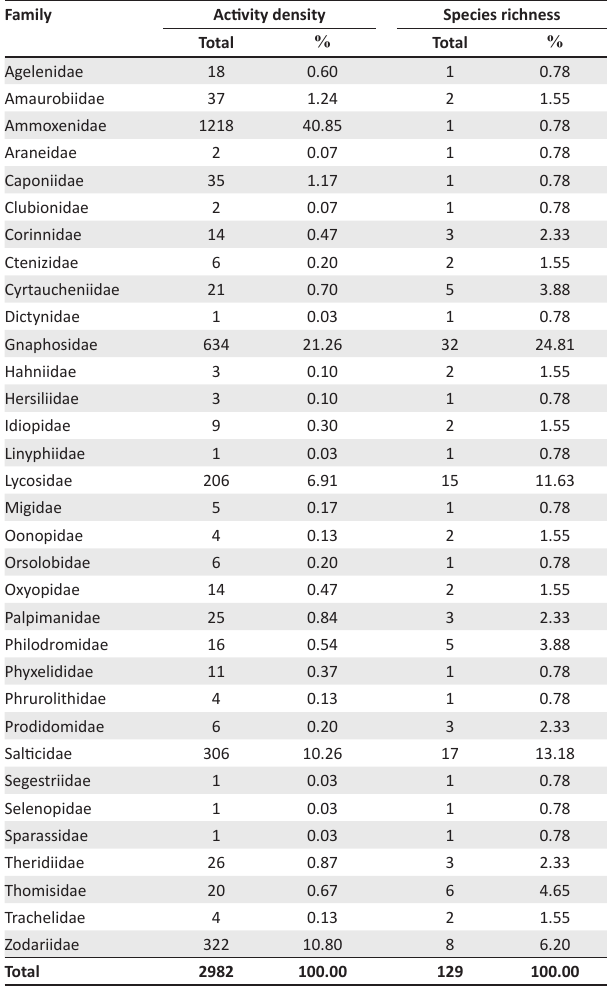
TABLE 2: Family activity density and species richness of ground-dwelling spiders sampled by pitfall trapping from eight habitats in the Amanzi Private Game